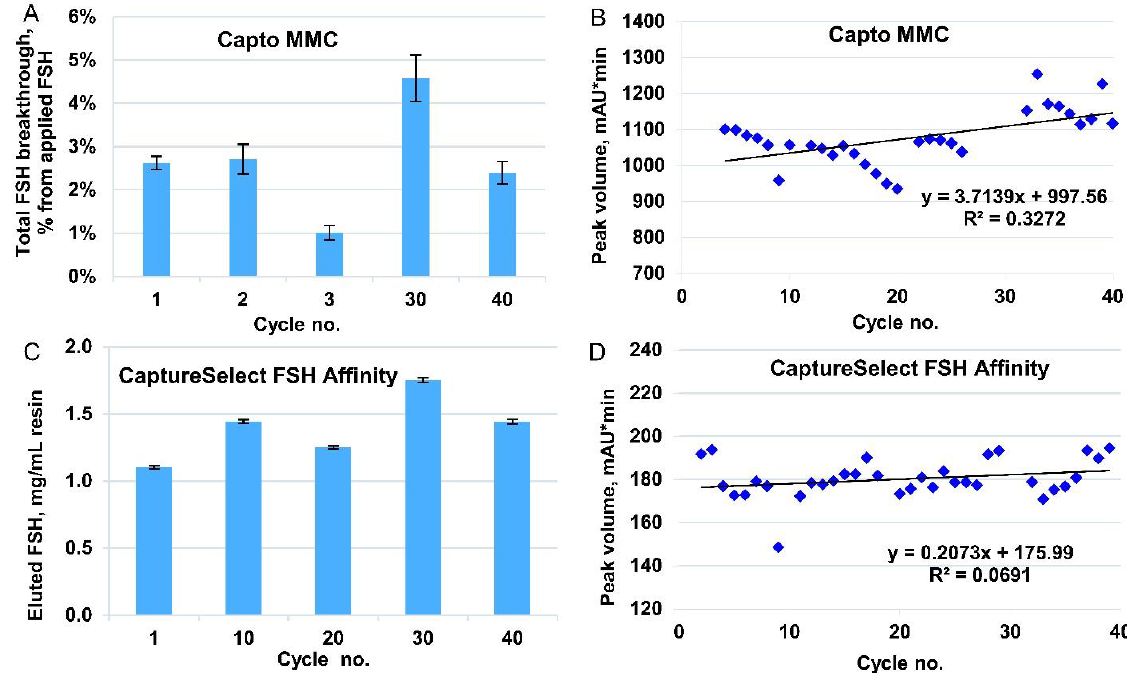
Figure 2. Stability studies for multimodal chromatography (step 1) and immunoaffinity chromatog- raphy (step 2). ( A ) Total FSH breakthrough at applying 1.9 mg FSH/mL Capto MMC resin